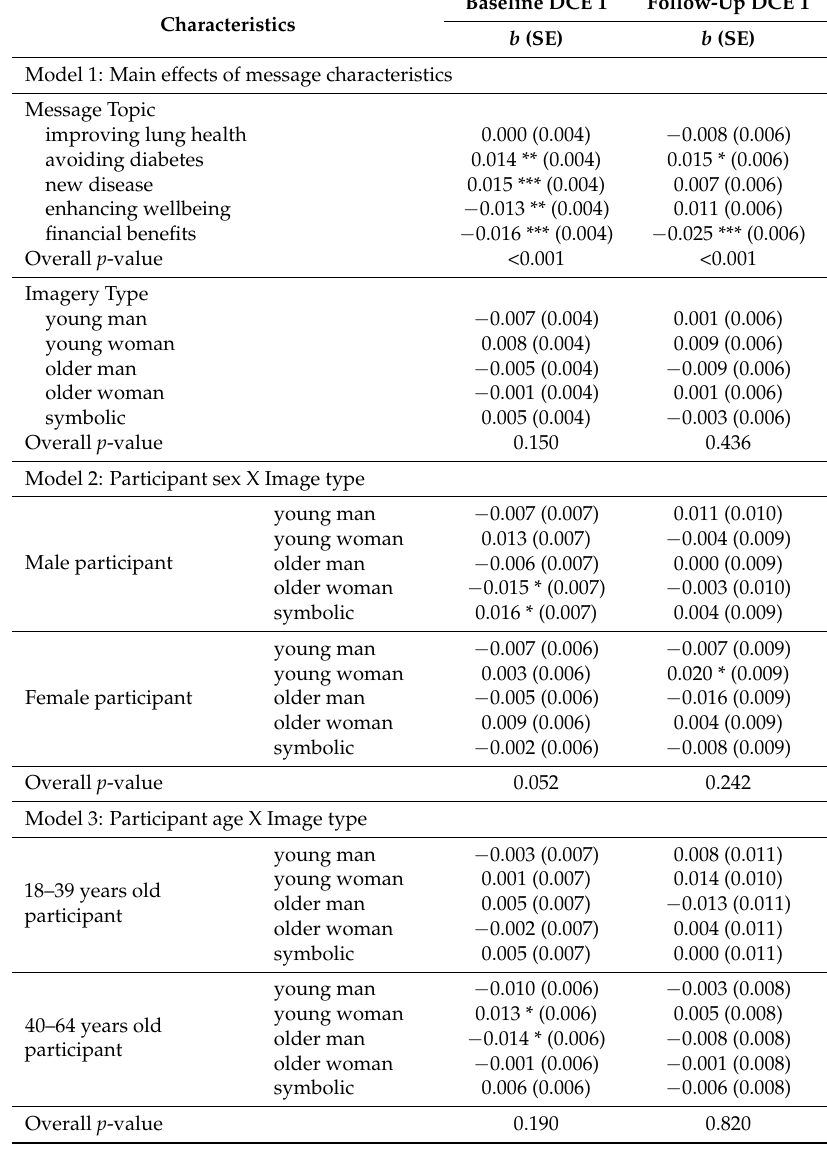
Table 2. Effects of cessation benefit message characteristics on quit